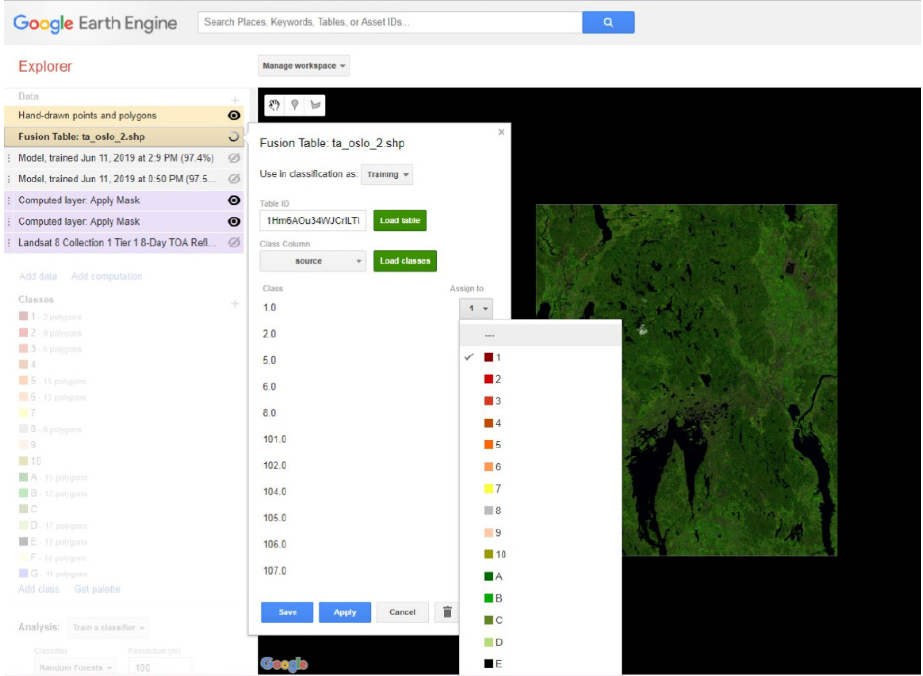
Figure 10. LCZ classification in Google Earth Engine with the clipped Landsat 8 image.